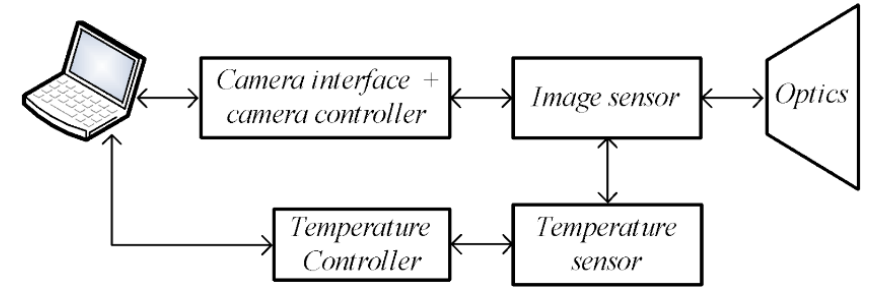
Figure 1. The architecture of the breadboard. All components used in implementing the camera breadboard are COTS devices. The selected image sensor was an Aptina MT9J001 monochromatic CMOS sensor of 10 megapix- els (MP). This sensor is similar to the one proposed by the APST STR [6]. The specifications of the sensor are presented in Table